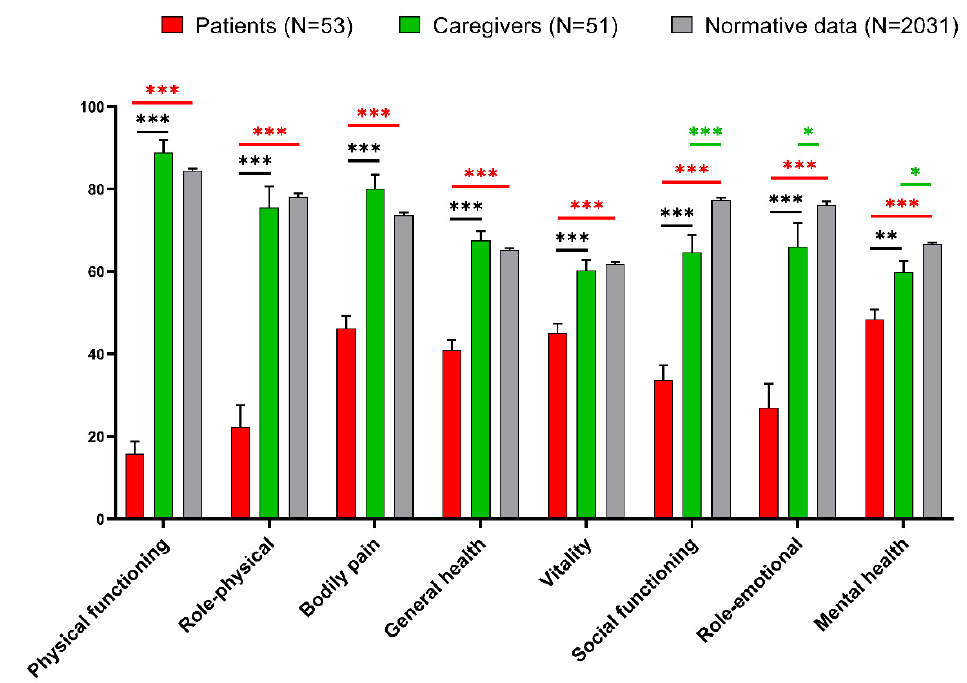
Figure 4. 36-Item Short-Form Health Survey (SF36) data from patients and caregivers, together with normative Italian data. The asterisks indicate a statistically significant difference between groups, according to the post hoc analysis (* p < 0.05, ** p < 0.01, *** p < 0.001). Red asterisks refer to the comparison patients-normative data, green asterisks refer to the comparison caregivers-normative data, and black asterisks refer to the comparison patients-caregivers.